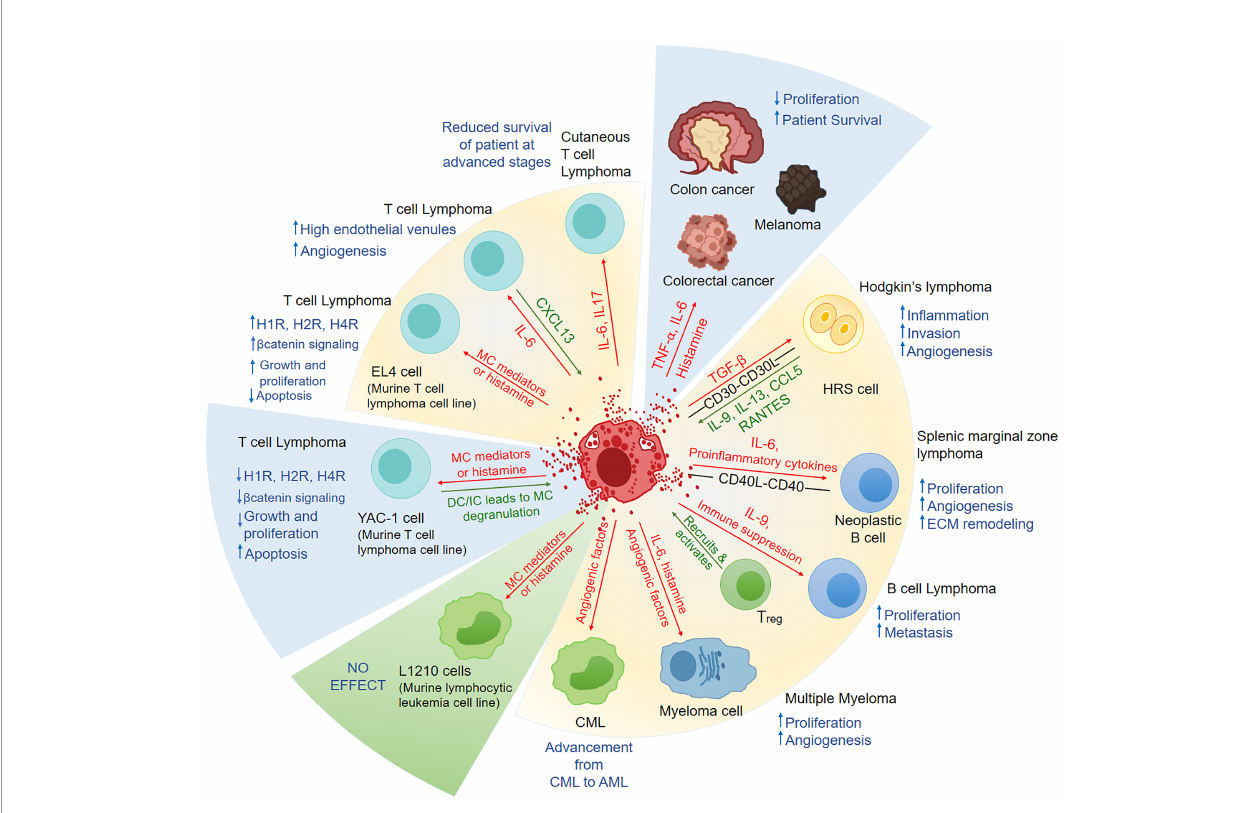
FIGURE 1 | A summary of the factors released by mast cells and their physiological response in hematological malignancies and solid cancers. In Hodgkin ’ s lymphoma, splenic marginal zone lymphoma, B cell lymphoma, CML, T cell lymphoma, and myeloma MCs have been shown to play pro-tumorigenic role. In an in-vitro study, MCs had an anti-tumorigenic effect in T cell lymphoma but had no effect in murine lymphocytic leukemia. In some solid cancers, like colon cancer, melanoma and colorectal cancers, MCs have been shown to play anti-cancerous role. The factors released by MCs are represented by red arrows in this fi gure, while the factors/chemokines released by leukemia/lymphoma cells are represented by green arrows. Blue upwards arrow represents the increase and blue downwards arrow represents the decrease, as a result of the effect of MC on the malignancy. In the pie representation, blue slice represents the anti-cancerous role, green slice represents No effect and yellow represents pro-tumorigenic role played by MCs. MC, Mast cell; HRS, Hodgkin ’ s and Reed-Sternberg cells; ECM, extracellular matrix; Treg, Regulatory T cells; CML, Chronic myeloid leukemia; AML, acute myeloid leukemia; H1R:, H1 Histamine Receptor; H2R, H2 Histamine Receptor; H4R, H4 Histamine Receptor; DC, Direct contact; IC, Indirect contact means MCs treated with tumor cell supernatant